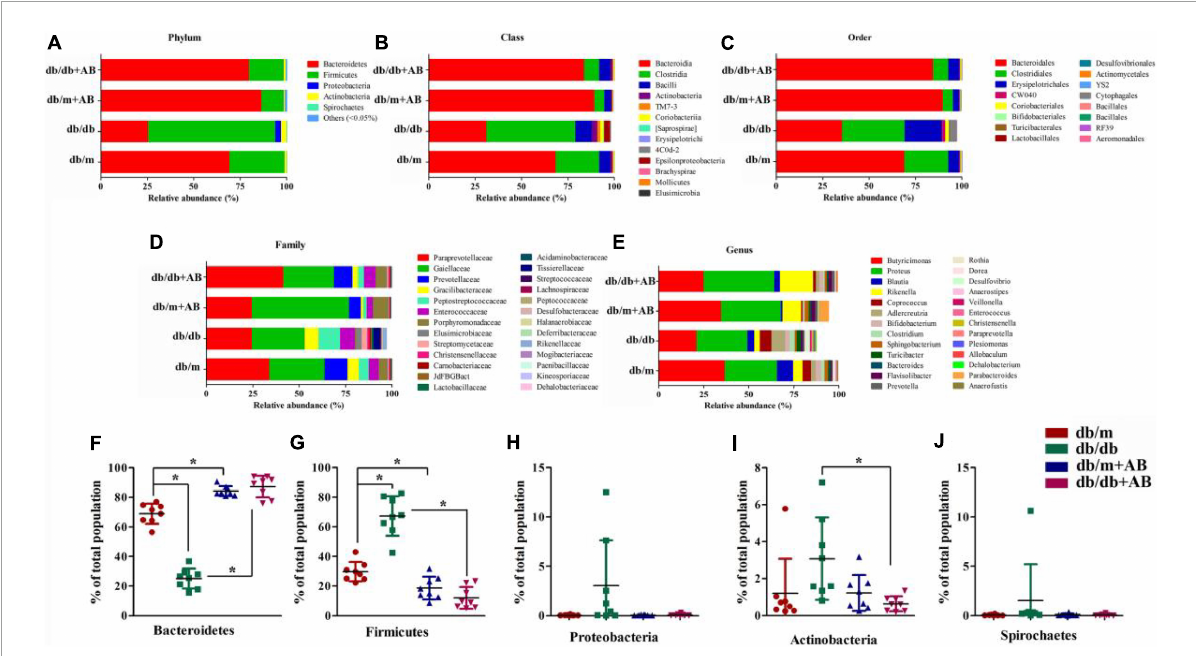
FIGURE2 Obesity induced gut microbiota dysbiosis. Representative charts of relative abundance of bacterial phyla (A) , class (B) , order (C) , family (D) and genus (E) in gut microbiota of Lepr db / db and Lepr db / m mice treated with neomycin or not, and relative proportion per group of different phyla (F–J) . n = 8 in per group. * P <